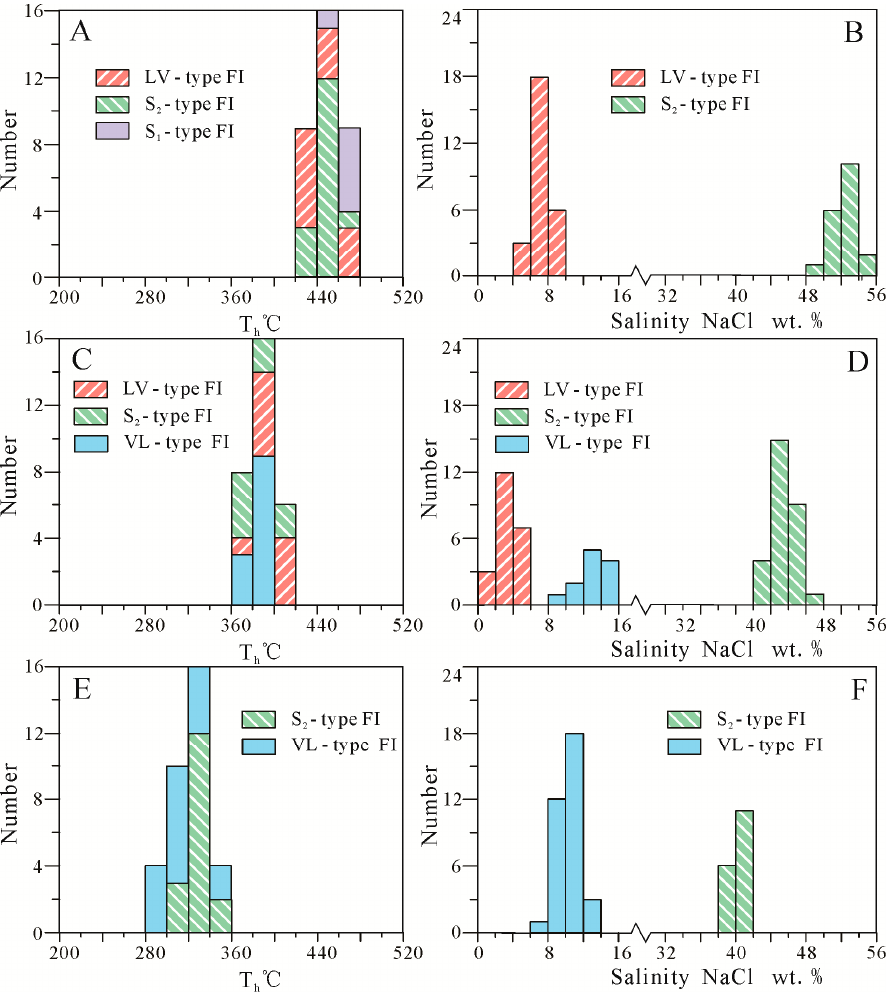
Figure 8. Histograms of microthermometric data for fluid inclusions in hydrothermal quartz from the Jinchang deposit. ( A ) Homogenization temperatures of S 1 -, S 2 -, and V-type FIs in Stage 1 quartz; ( B ) salinity data for S 2 - and V-type FIs in Stage 1 quartz; ( C ) homogenization temperatures of S 2 -, V-, and LV-type FIs in Stage 2 quartz; ( D ) salinity data for S 2 -, V-, and LV-type FIs in Stage 2 quartz; ( E ) homogenization temperatures of S 2 - and LV-type FIs in Stage 3 quartz; ( F ) salinity data for S 2 - and LV-type FIs in Stage 3 quartz.